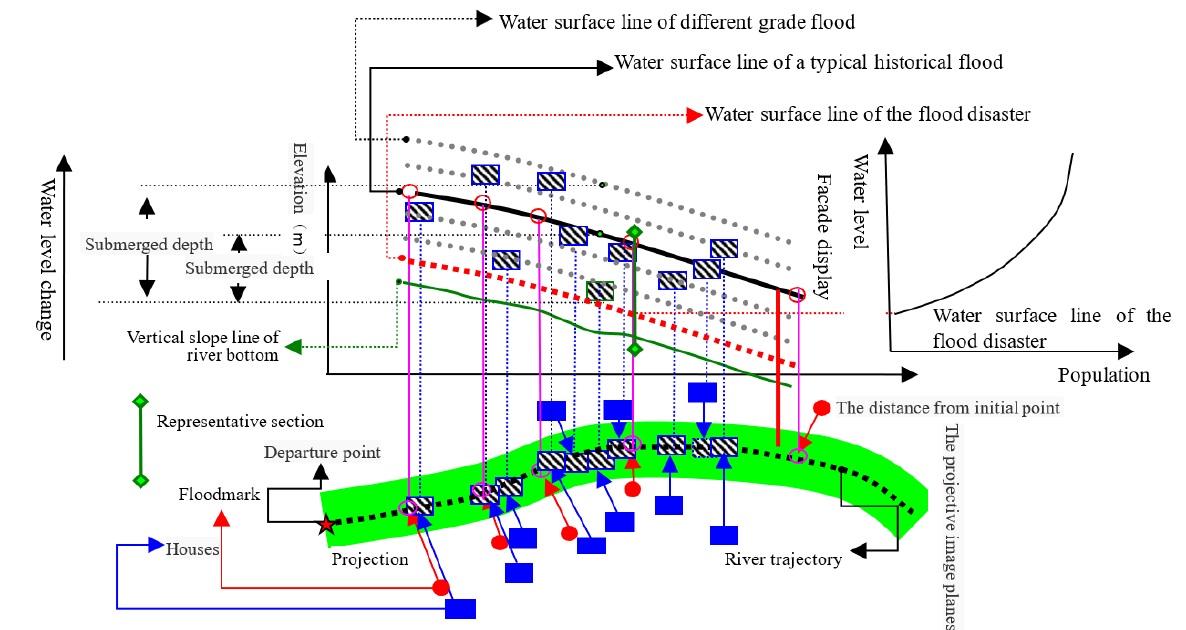
Figure 2. Schematic diagram of double projection water level and flooding affect population.